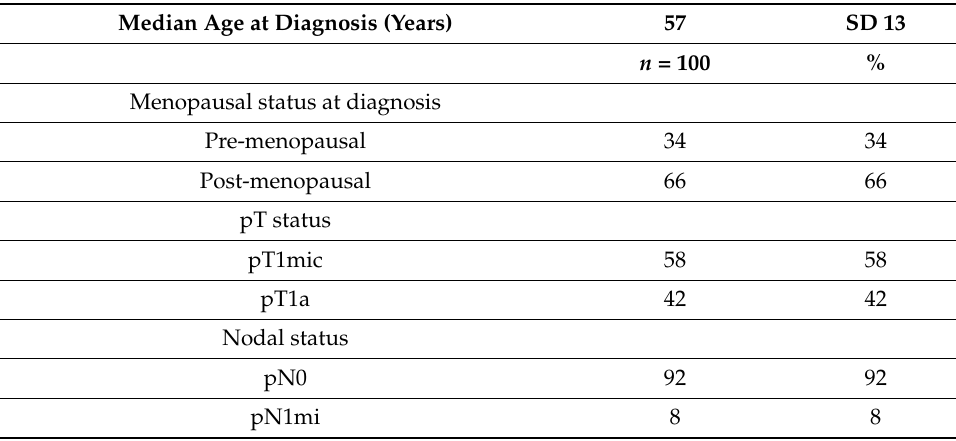
Table 1. Data of the study population (total of 100